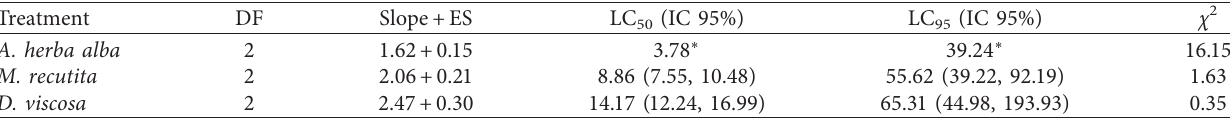
Table 5: LC50 and LC95 values ( μ L/1litre of air) calculated for mortality of C. maculatus adults after 24h of postcontact with various concentrations of essential oils.